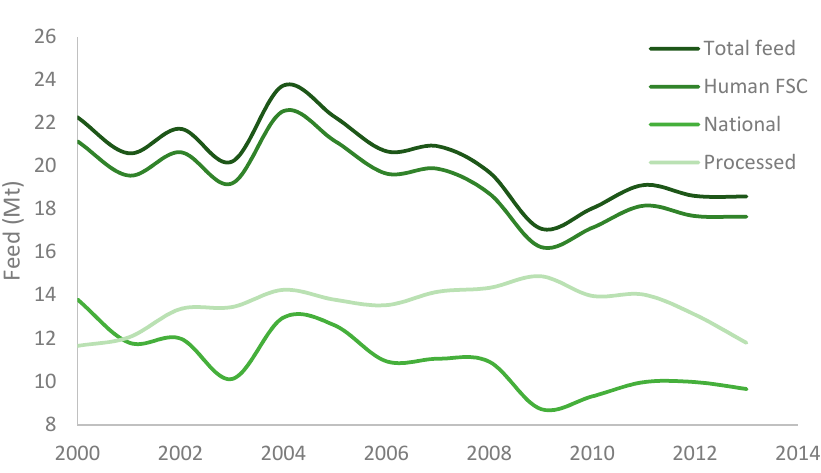
Figure A2. Total feed, feed for use in the human FSC, feed from national products and processed feed.